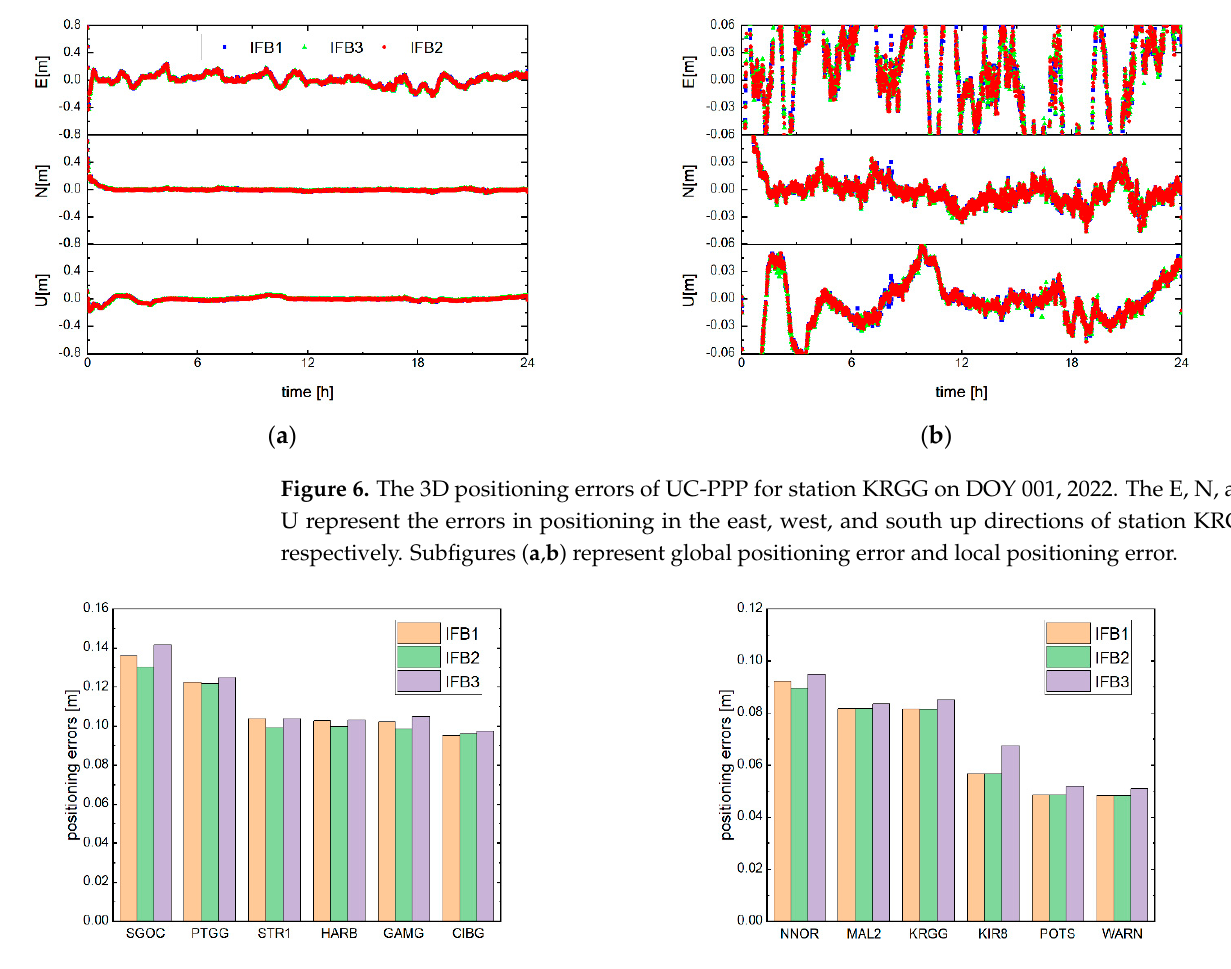
Figure 7. The positioning errors of UC-PPP for different schemes. Subfigure ( a ) is used to represent the stations whose positioning accuracy is greater than 0.1 m, and subfigure ( b ) is for other stations.